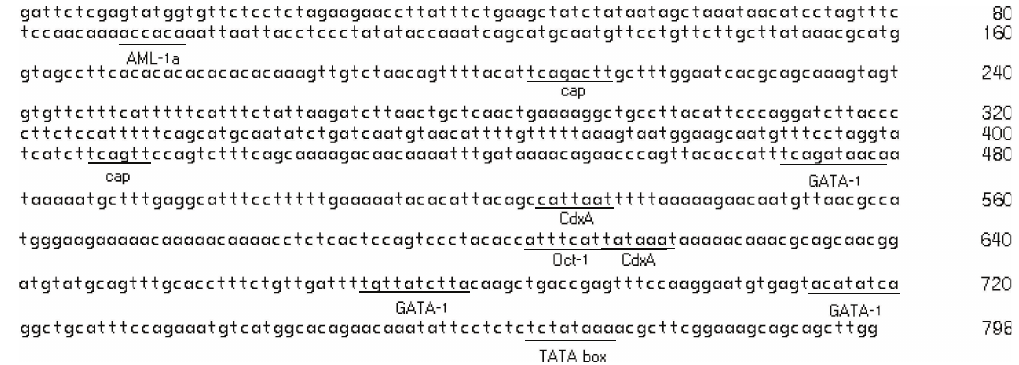
Figure 3: Online prediction of transcription factor binding sites and the TATA box in the 5 (cid:2) flanking region of the dGHRL gene.